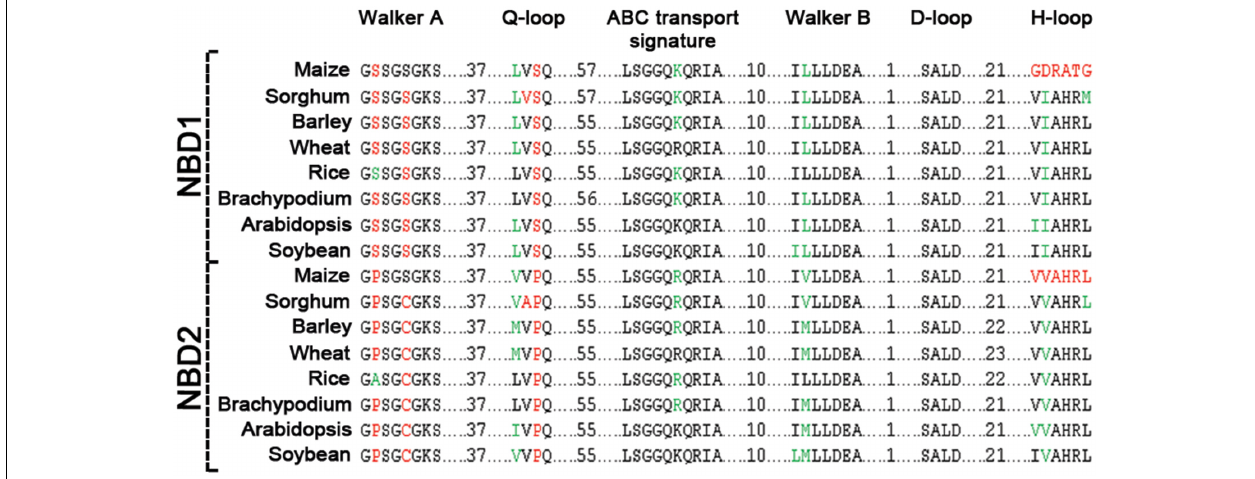
FIGURE 3 | Sequence comparison of motifs between NBD1 and NBD2 of ABCB1. Conserved residues between two domains are highlighted in black, synonymous changes in green and non-synonymous changes are in red.